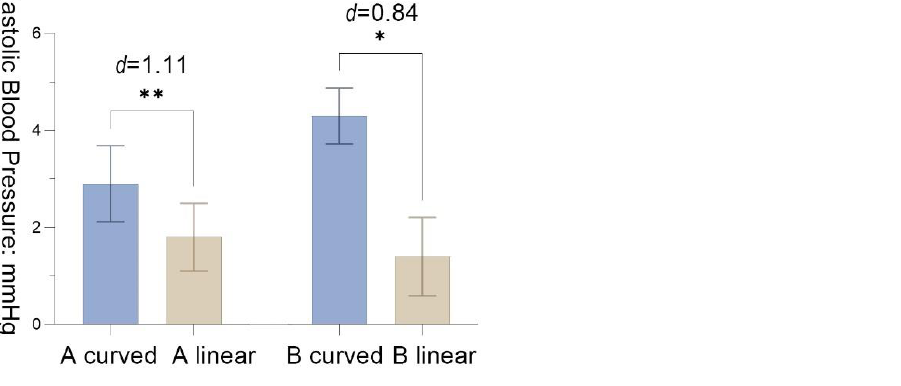
Figure 8. The results of diastolic blood pressure with the standard error mean bars; significance levels: * p < 0.05, ** p < 0.01; effect size (d): negligible (<0.2), small (0.2–0.5), moderate (0.5–0.8), and large effect (>0.8).